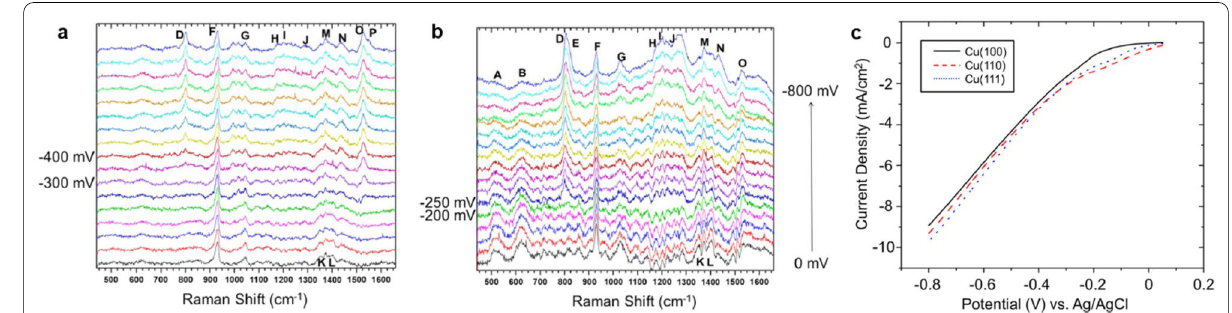
Fig. 10 In situ Raman spectra of a Cu(100) and b Cu(110) electrodes measure in a 0.1 M HClO 4 /0.05 M HNO 3 solution during cathodic polarization from 0 to 800 mV vs. Ag/AgCl. c Linear sweep voltammetry of Cu(100), Cu(110), and Cu(111) electrodes in a 0.1 M HClO 4 /0.05 M HNO 3 solution during cathodic polarization from 0 to 800 mV vs. Ag/AgCl, reproduced with permission from [50]. Copyright (2016) Elsevier